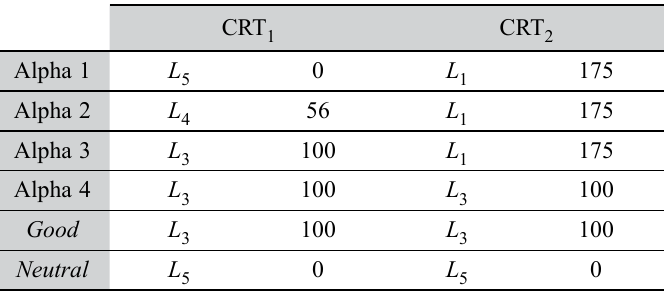
Table 3. Levels and partial values revealed by the evaluated branches CRT 1